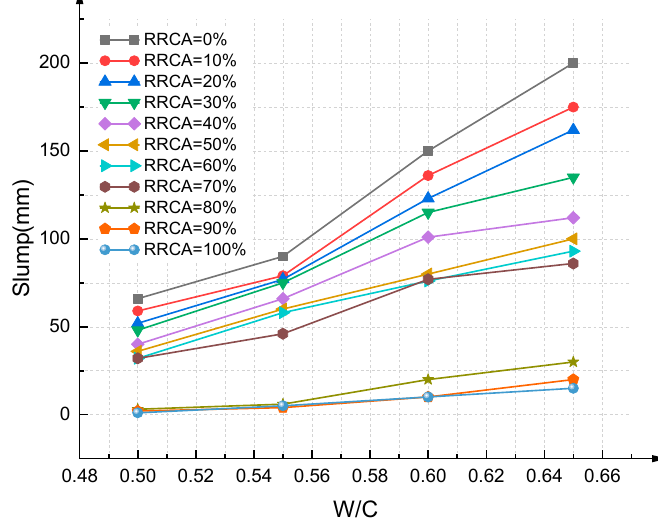
Figure 10. Effect of water–cement ratio on slump (P1).